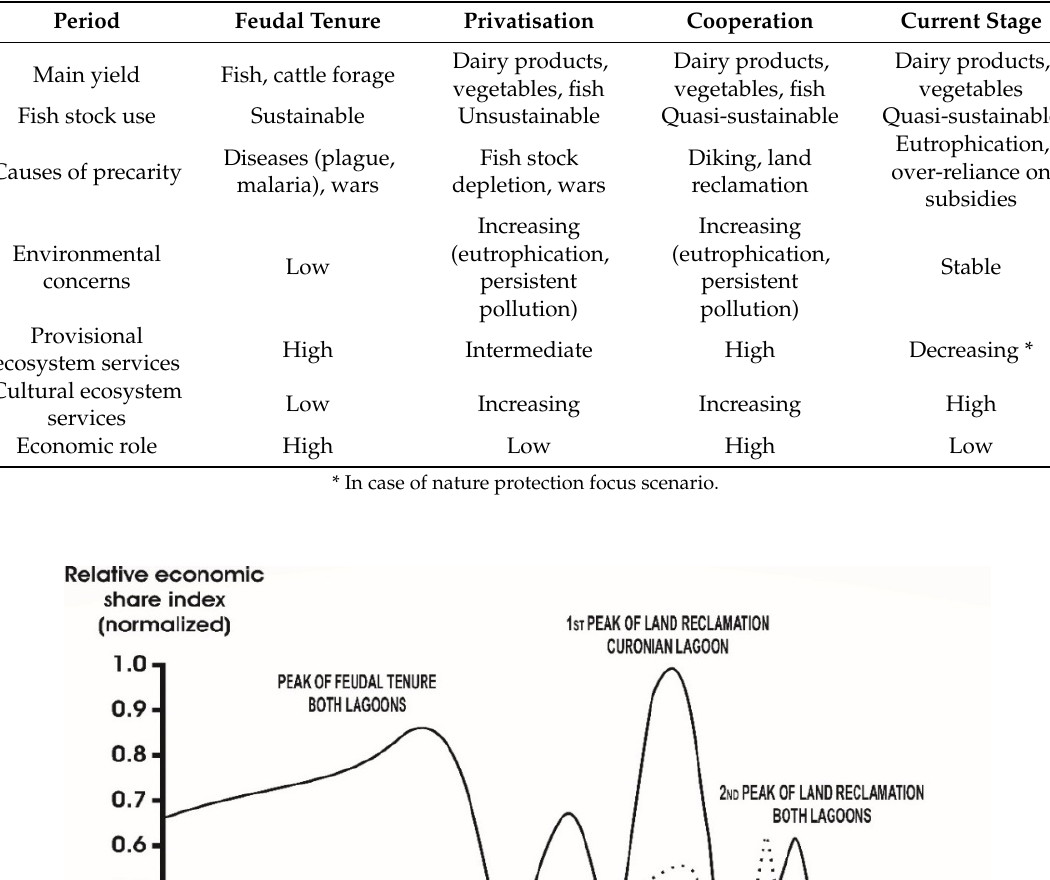
Table 3. Emerald Growth in the European lagoons in the modernity.